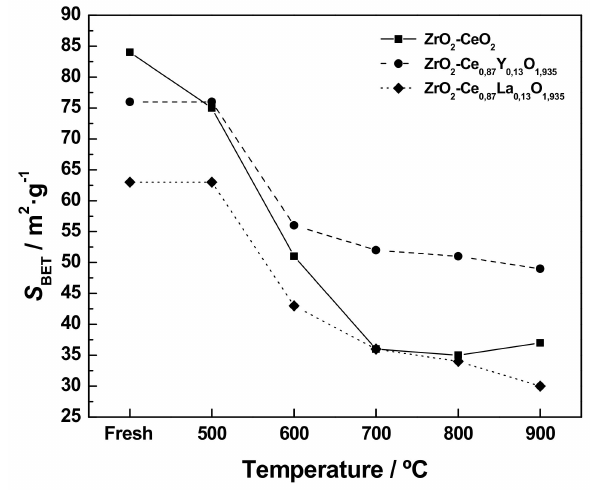
Figure 8. Evolution of S BET with the maximum temperature of the last reduction treatment for the undoped and Ln-doped ZrO 2 -CeO 2 samples during the application of the successive thermochemical ageing